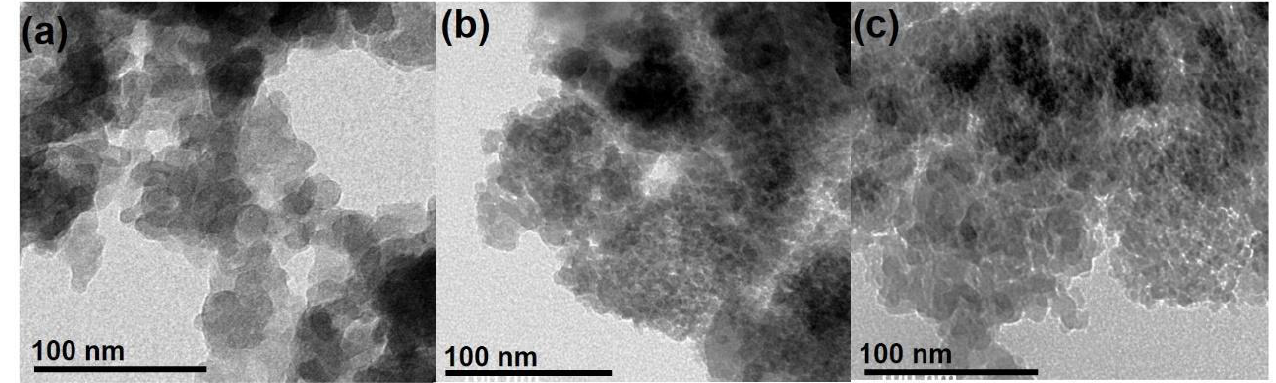
Figure 3. SEM images of SiO 2 nanoparticles: ( a ) AC, ( b ) SG, and ( c ) RH. Specific surface area (SSA) data and pore size salient parameters for the silica samples (before and after TMSCl treatment) are reported in Table 1. In particular, the average particle size (estimated by TEM), micropore area (A Pore ), external area (A Ext ), total surface area (A Pore + A Ext = SSA BET ), and pore diameter are